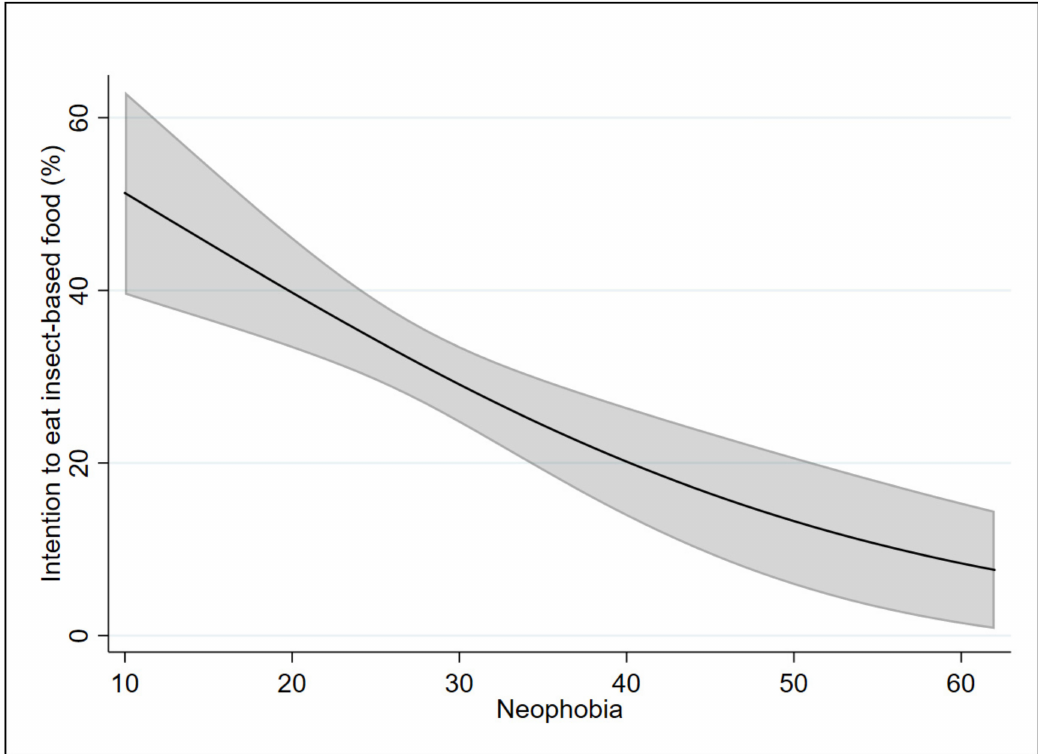
Figure 2. Marginal effects of the neophobia scale on Model 2 with 95% confidence